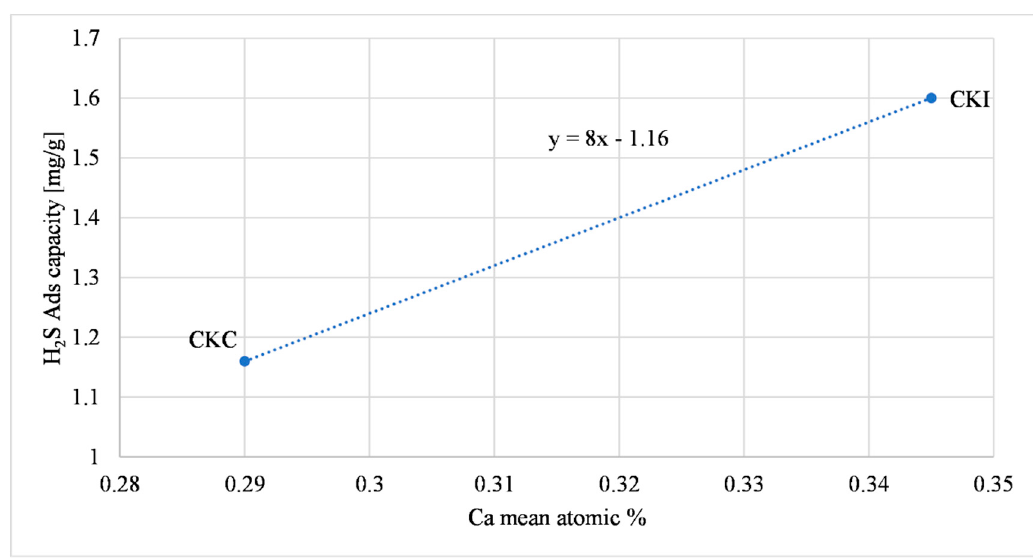
Figure 6. Calcium oxide effect on H 2 S adsorption.